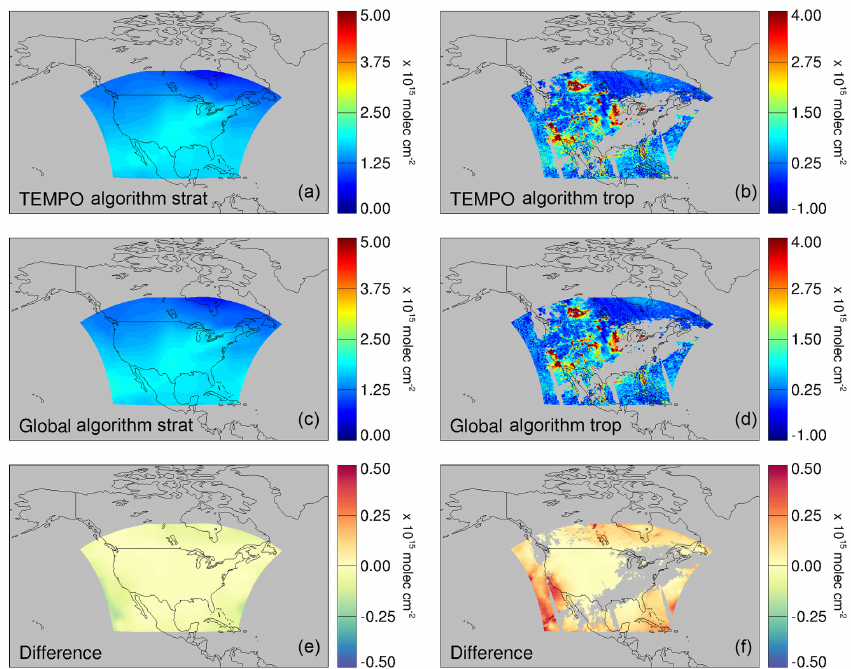
Figure 7. Stratospheric NO 2 (a, c, e) and final tropospheric NO 2 retrievals (b, d, f) resulting from our algorithms for 15 January 2007. Panels (a, b) show the results using our proposed TEMPO algorithm. Panels (c, d) show the results using global observations (results have been clipped to the TEMPO field of regard for comparison). Panels (e, f) show the absolute differences between the TEMPO and global algorithm results.